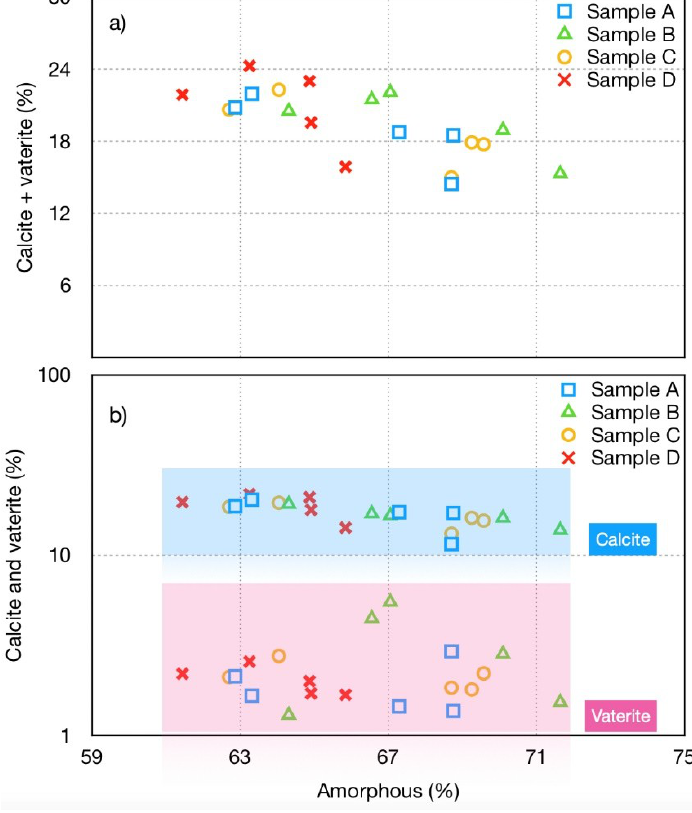
Figure 4. Amount of crystalline calcium carbonate phases (calcite and vaterite), evaluated as a global calcium carbonate crystalline phases ( a ) and separately ( b ). These data were calculated by Rietveld method, in respect to corresponding amorphous content.